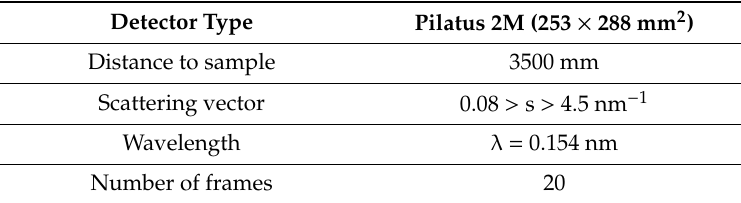
Table 2. SR-SAXS experimental